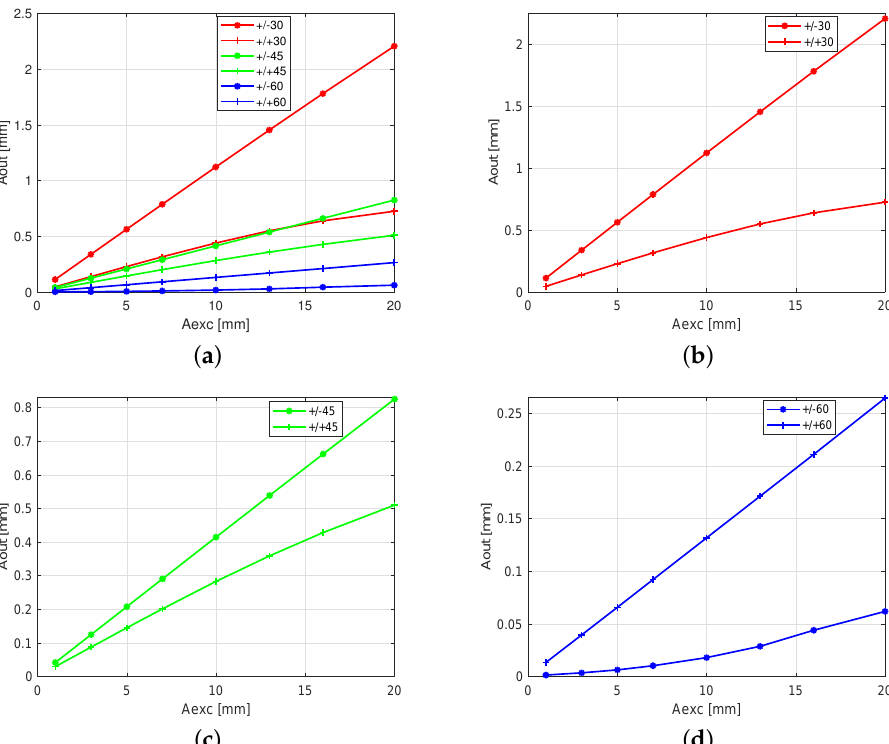
Figure 5. Response amplitude for all analyzed cases of fiber orientations against the increased excitation amplitude: ( a ) A exc = 1 mm, 3 mm, 5 mm, 7 mm, 10 mm, 13 mm, 16 mm, and 20 mm, respectively, and ( b – d ) the magnified results of the three fiber configuration cases.